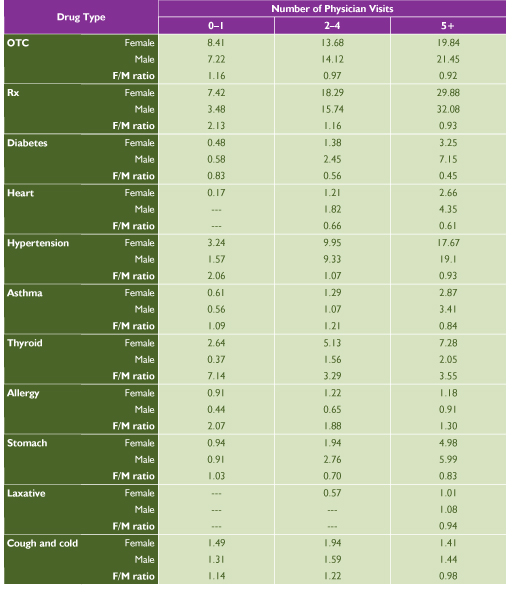
Sex Specific Prevalence of Medication Use by Number of Physician Visits and Medication Type. (Not Age-Standardized) Source: Statistics Canada, NPHS, 1996–1997